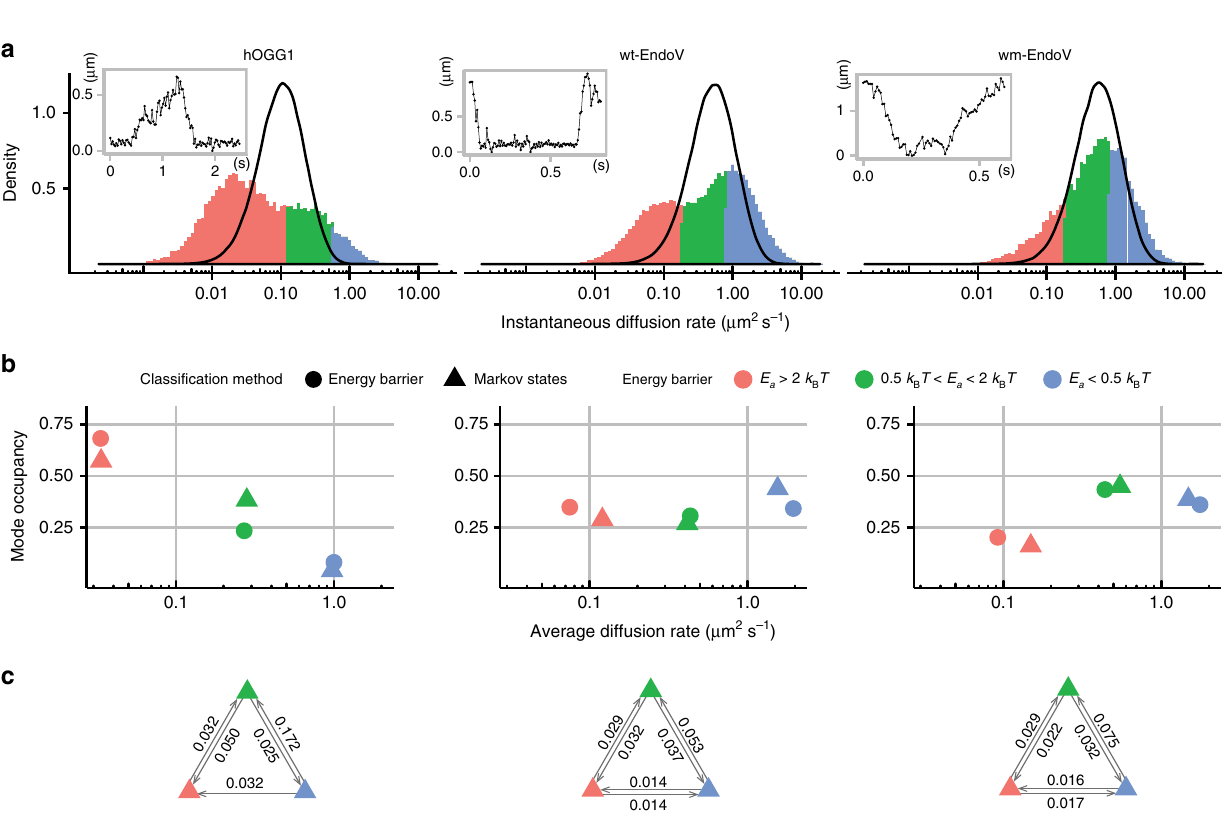
Fig. 2 Diffusion analysis. a Distribution of instantaneous diffusion coef fi cients computed for hOGG1 (697 trajectories) with sliding window of 117.5 ms, and for wt- and wm-EndoV (wt-EndoV: 3443 trajectories, and wm-EndoV: 1099 trajectories) using sliding window of 37.5 ms. Insets: examples of single trajectories for each protein with time on the x -axis and displacement on the y -axis. b Comparison of classi fi cations based on activation energy barrier (circles) and on Markov hidden state models (triangles), showing strong agreement between methods. The state occupancy is the proportion of time that proteins spend in each of the classi fi ed modes. The standard error of the mean of the average diffusion rate for all points is below 0.02 µ m 2 s − 1 . c Inter-state transition probabilities of the hidden Markov models. Arrows between triangles show transition probabilities for the transitions between the respective scanning modes, colored according to the energy